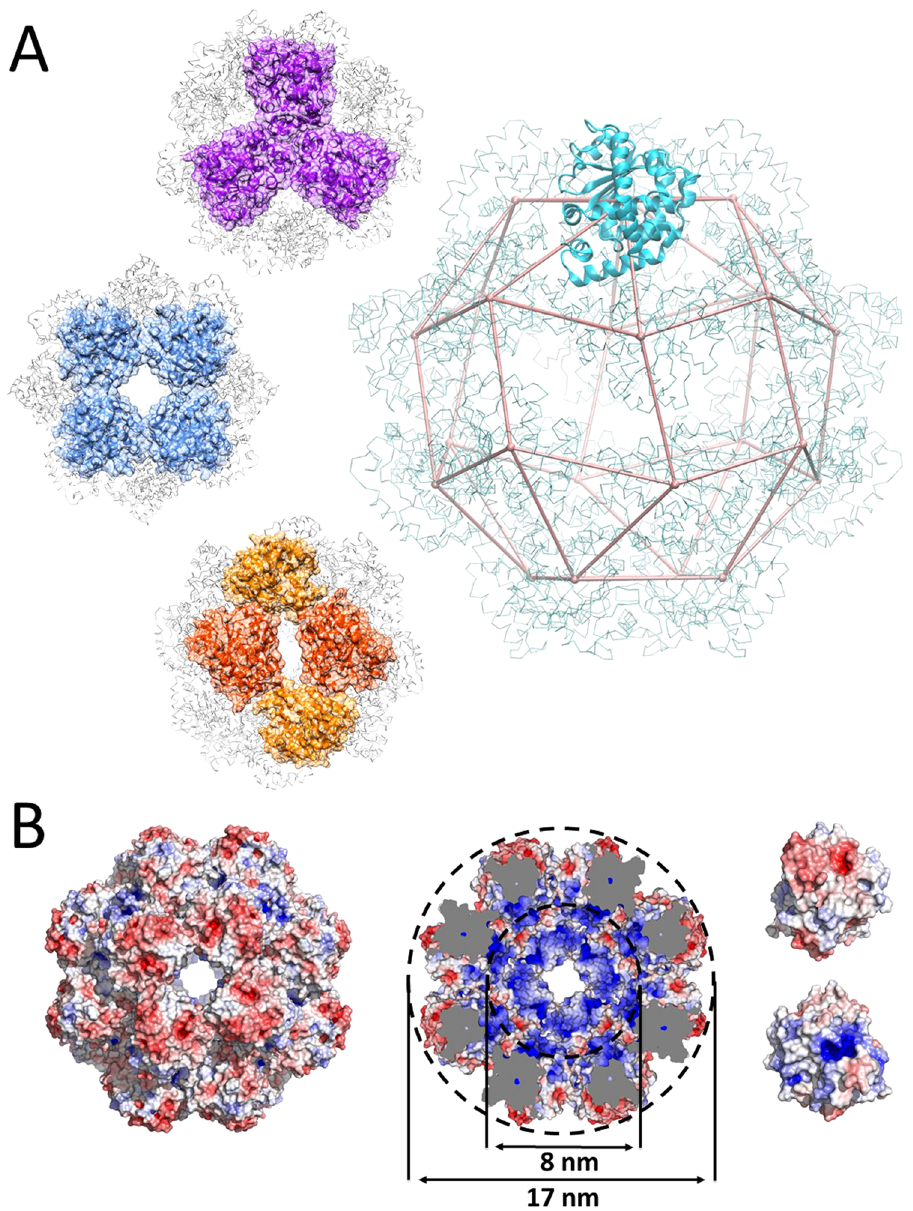
Figure 2. Atomic models of the tetracosameric assembly of α -TTP S . ( A ) View of the atomic model along the three symmetry axes; four-fold in blue (channel width ≈ 21 Å), three-fold in purple and two-fold in orange. In the centre a geometric representation of the twisted cantellated cube (TCC) with a ribbon cartoon of a monomer sitting on a node is shown. ( B ) Electrostatic maps of the tetracosameric assembly and of α -TTP; the outer sphere surface of the tetracosamer is mainly negatively charged (left) whereas its interior is mainly positively charged (middle); electrostatic maps of the external and internal faces of α -TTP